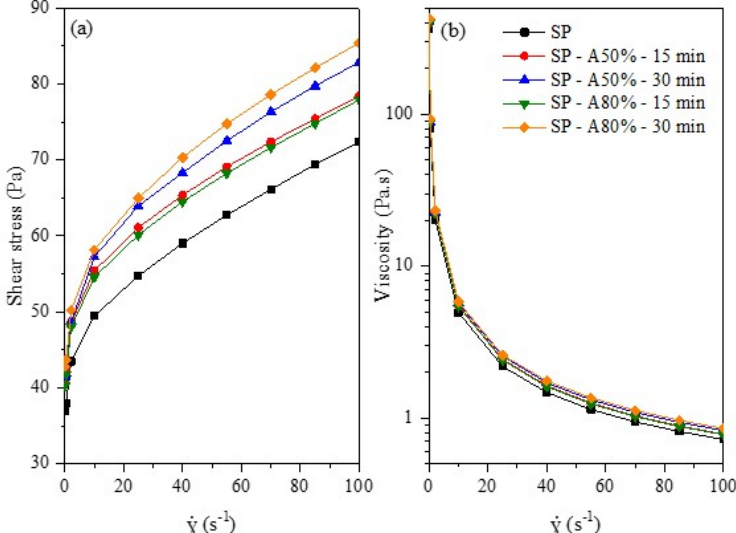
Figure 6. Flow curves (a) and viscosity vs. shear rate curves (b) of cement pastes evaluated after 10 min of hydration.